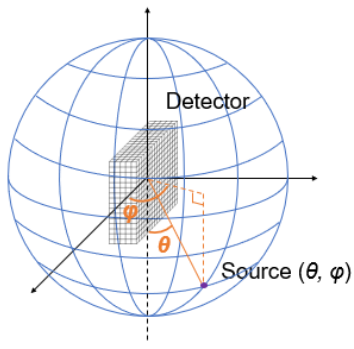
Figure 2. Illustration of the geometrical setup of the imaging problem.